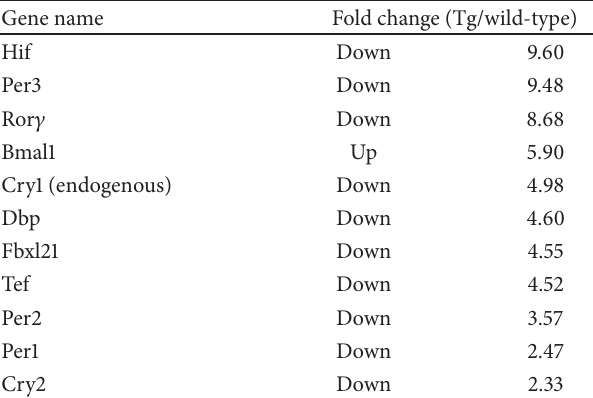
Table 1: Expression change in clock-related genes of isolated islets. Themice were kept in LD 14:10 as described [15]. The